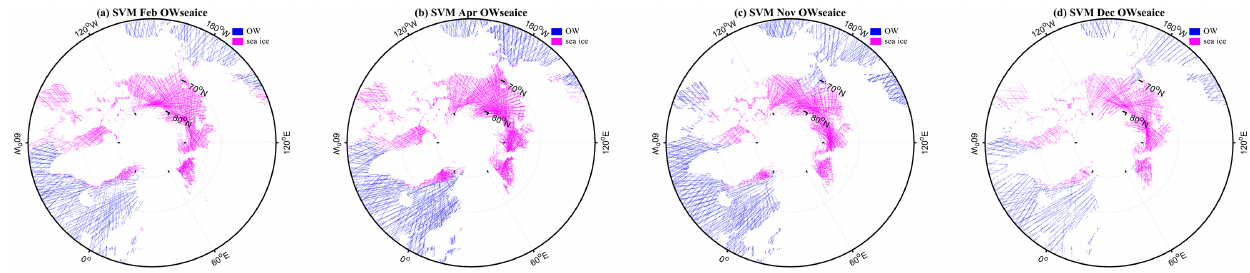
Figure A7. SVM for OW-sea ice classification using the data in March as the training set. The data in ( a ) February, ( b ) April, ( c ) November, and ( d ) December are used as the test set in turn.